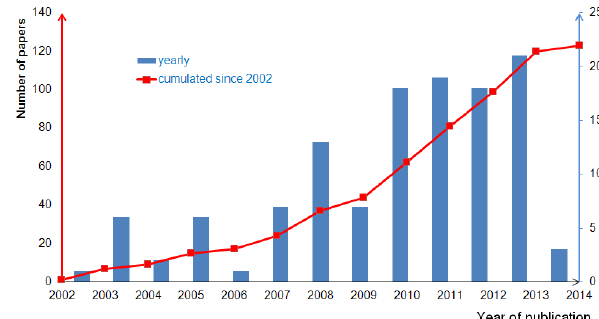
Figure 2. Increase in the number of papers ( N ) dealing with terroir zoning from 2002 to March 2014. Source: Web of Science (v.5.14, 2014).